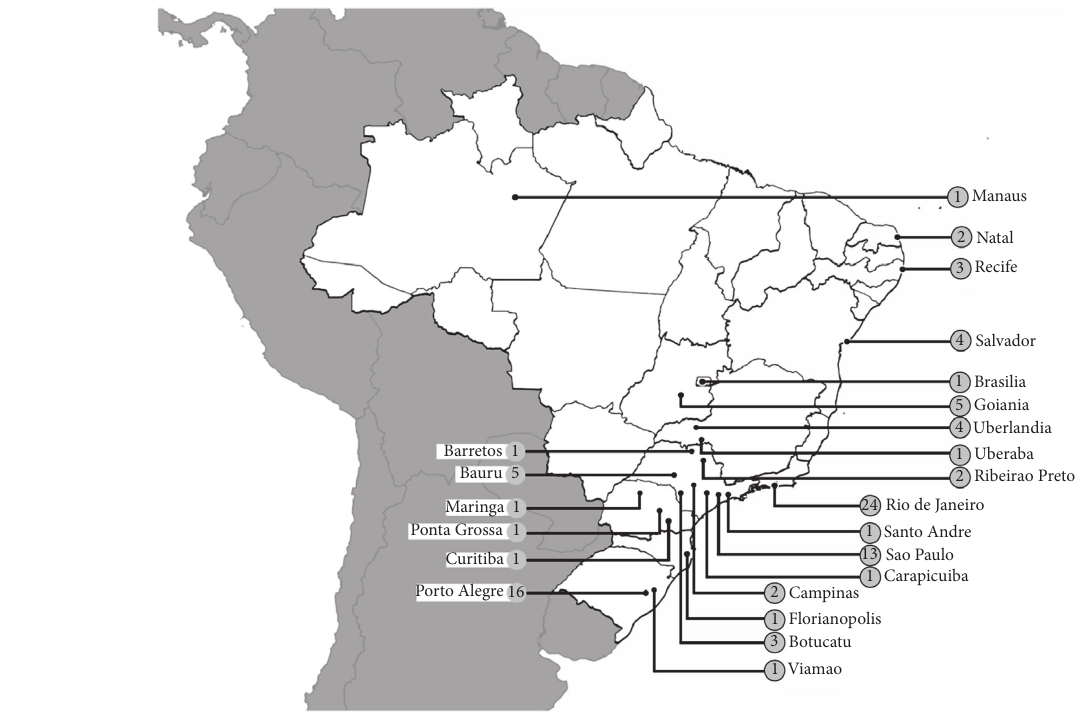
Figure 3: Map with georeference of MRSA reports showing the number of publications by isolation location during the